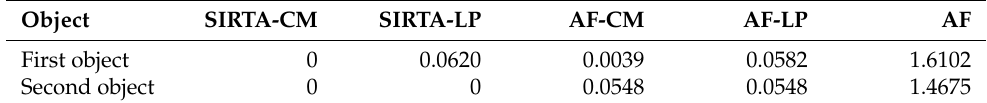
Table 4. NRMSE with ∆ η =